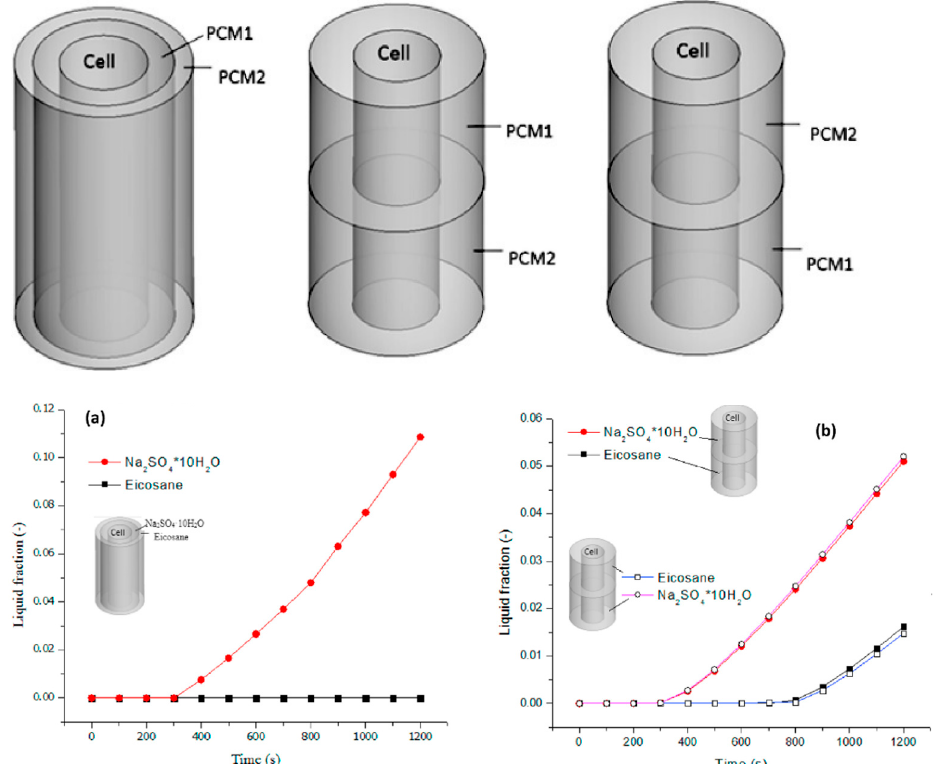
Figure 8. ( top ) The BTMS with two different PCMs described in [48] with trans-radial ( left ) and trans-axial ( middle , right ) arrangement. ( bottom ): The LF versus time for the three layouts: ( a ) trans-radial; ( b ) trans-axial. Reproduced with permission from